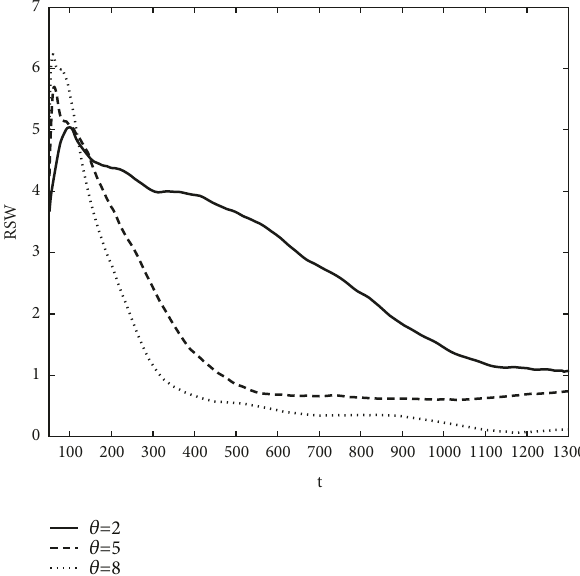
Figure 7: The evolution picture of the cluster innovation network Small-World